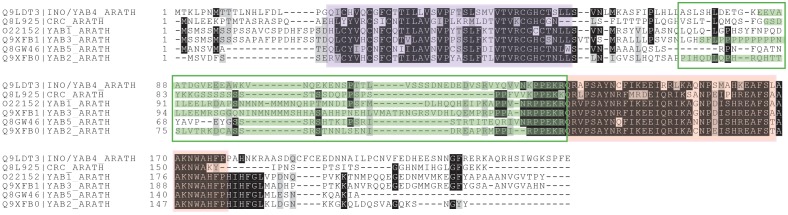
GCNA proteins in higher plants comprise the YABBY family.YABBY and GCNA proteins possess an IDR, a C2C2 zinc finger, and a characteristic two-helix HMG box (Bowman and Smyth, 1999). Regions are color coded as follows: IDR/'central variable region' (region outlined in green, with IUPred (Dosztányi et al., 2005) predicted disordered residues highlighted in green), C2C2 zinc finger (purple), and two-helix HMG box (pink). Residues that are identical in 70% of the sequences are shaded black; similar residues are shaded gray.